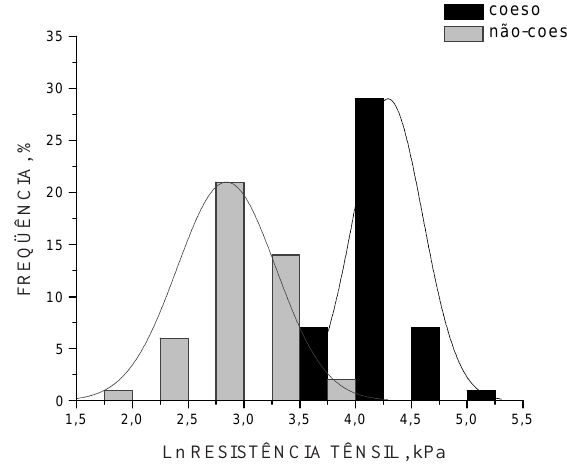
Figura 1. Freqüência de distribuição da resistência tênsil nos horizontes: coeso e